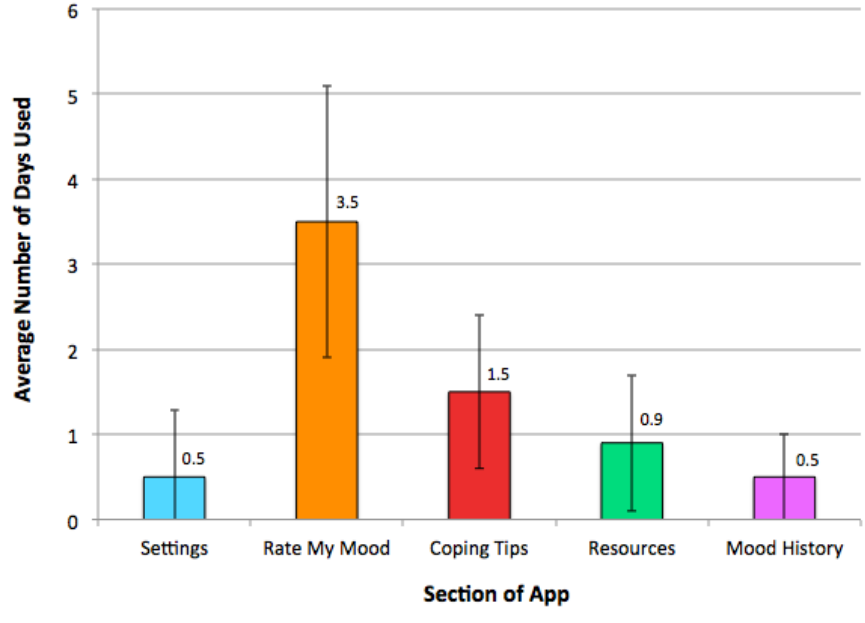
Figure 2. Average number of days within the usage period on which participants engaged with different sections of the app (within 1 standard deviation).